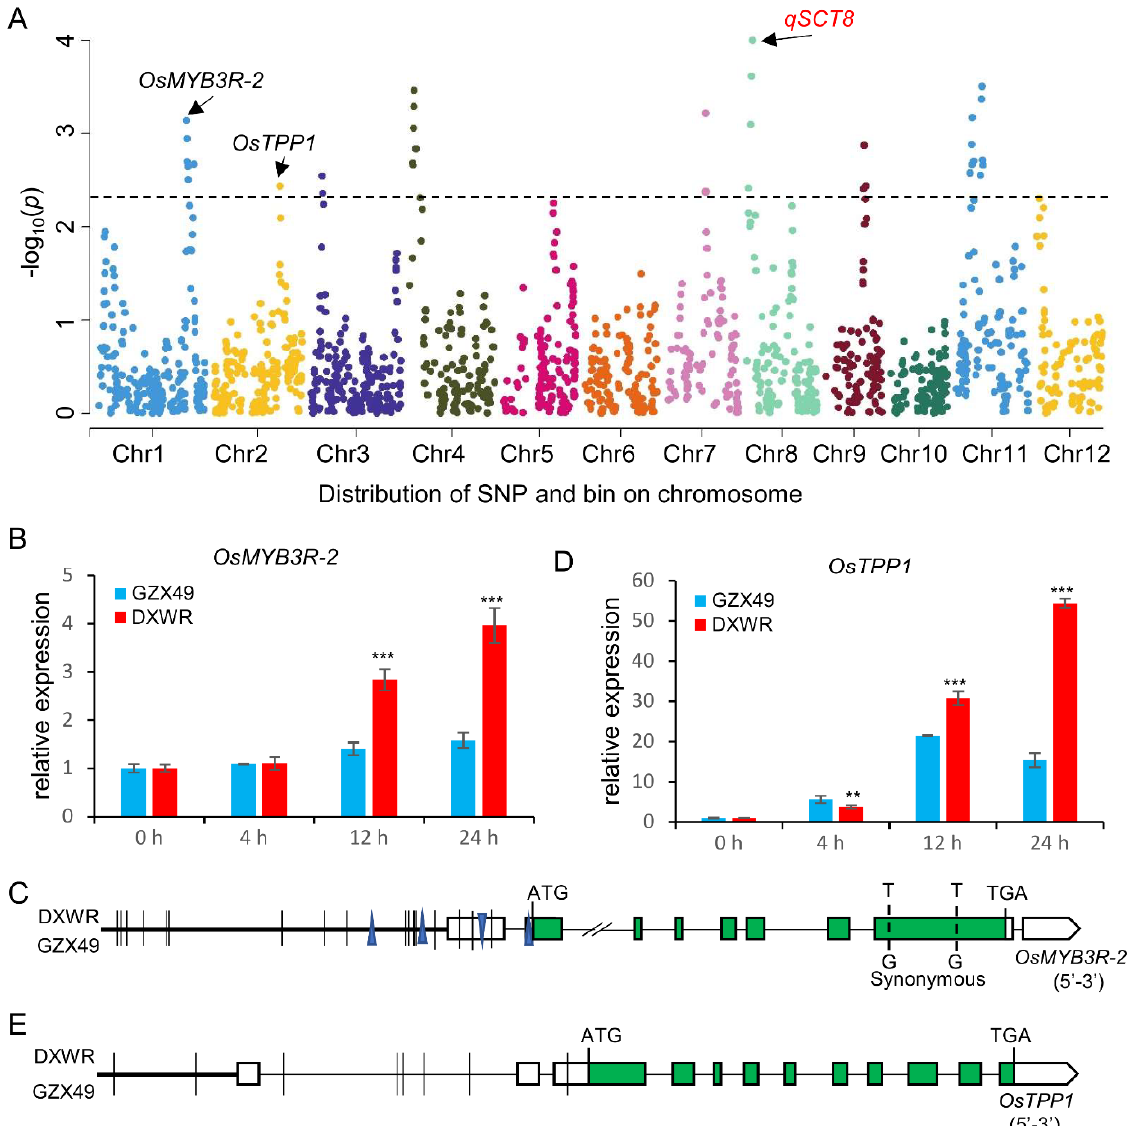
Figure 3. QTL analysis of the BRIL population. ( A ) Manhattan plots of the loci for seedling cold tolerance (SCT). The x -axis represents single nucleotide polymorphism (SNP) along each numbered chromosome; the y -axis represents the negative logarithm of the p -value (-log10 p) for the SNP association. Horizontal dashed lines in the plots indicate the declaration thresholds. ( B , D ) Expression levels of the OsMYB3R-2 and OsTPP1 in GZX49 and DXWR after cold stress measured by qRT-PCR, respectively. The results were statistically analyzed using Student’s t -test (** p < 0.01, *** p < 0.005). Transcription levels relative to 0 h, which was set to 1, are presented as the mean and SE of triplicates. LOC_Os03g13170 (Ubiquitin) is the control gene. ( C , E ) Sequence comparison of OsMYB3R-2 and OsTPP1 among GZX49 and DXWR. The vertical bars and triangle represent SNPs and nucleotide deletion, respectively.